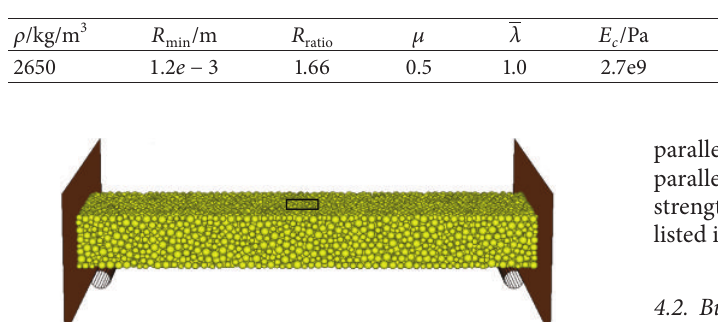
Figure 6: AE location of rock plate under uniform loading. Table 1: Microparameters of the model in PFC 3D .